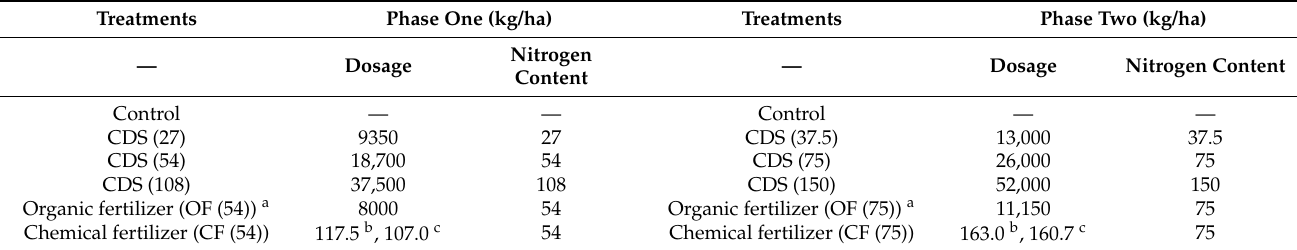
Table 3. Fertilizer dosage of different